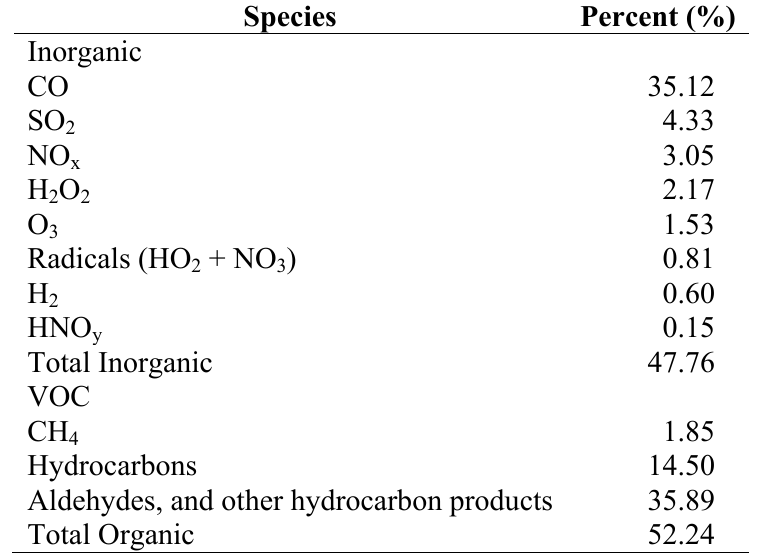
Table 4. Relative percentages of HO • radicals reacting with chemical species over the entire simulated